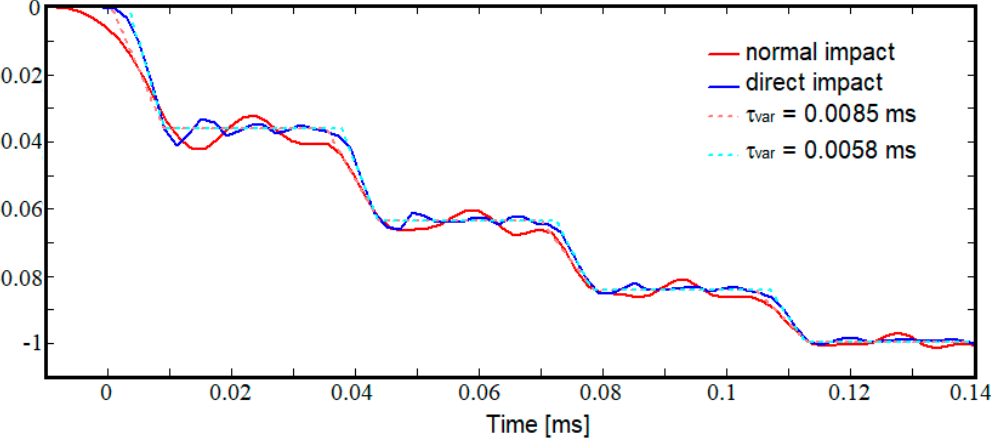
Figure 9. Comparison between the simulations results for the standard impact and direct